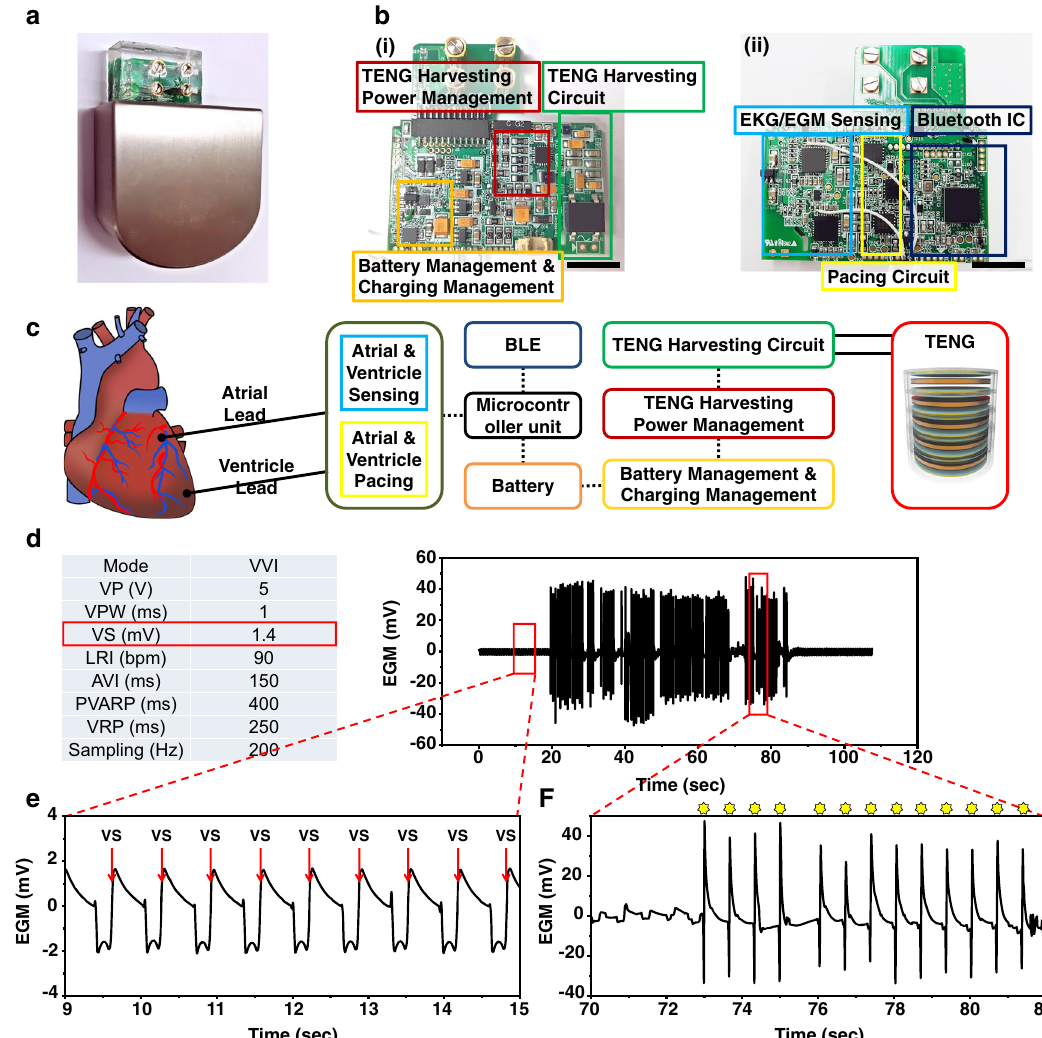
Fig. 6 Self-rechargeable cardiac pacemaker system. a Optical image of the self-rechargeable cardiac pacemaker. b Photographs of the (i) front and (ii) back of the integrated system. scale bar, 1 cm. c Functional block diagram of the self-rechargeable cardiac pacemaker. d Ventricular EGM signal from the in vivo animal experiment. e Ventricular EGM signals before adenosine injection. f Ventricular EGM signals with ventricle pacing after adenosine